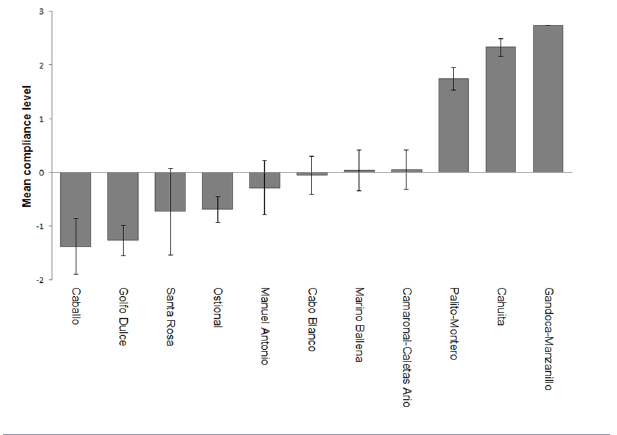
Fig. 2 . Mean perceived compliance level per marine protected area (MPA). Numbers on the y-axis indicate mean z-scores per MPA. Z-scores are standard deviations above or below the MPA population mean indicated by zero on the y-axis and representing the mean z-score across MPAs. Error bars indicate standard errors of the mean for each MPA, or variation between responses of interviewees for each